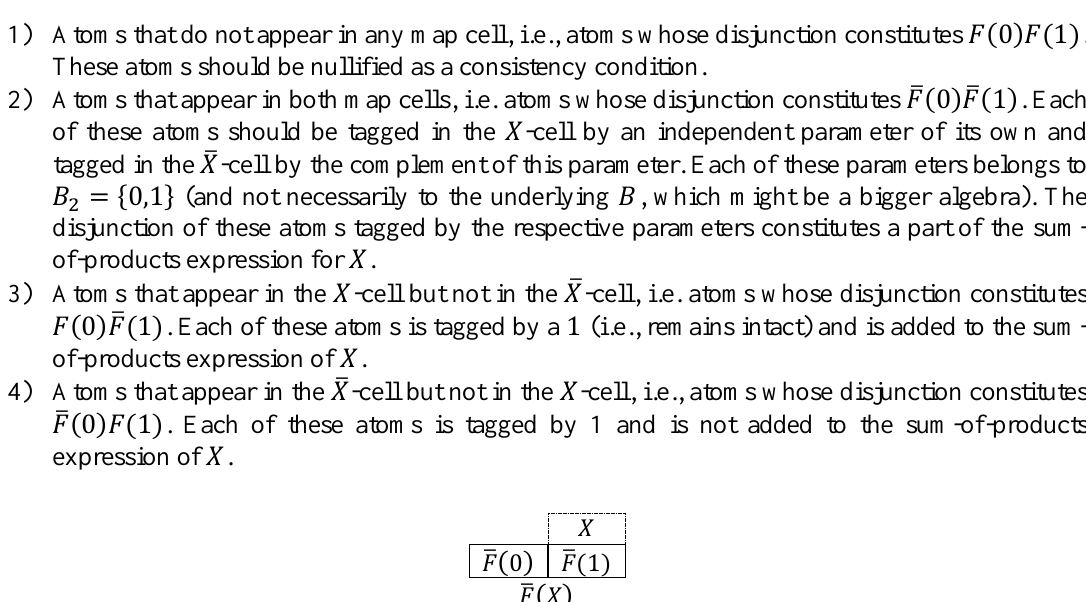
Figure A1. VEKM representation of 𝑭̅(𝑿) used in the equation 𝑭̅(𝑿) =